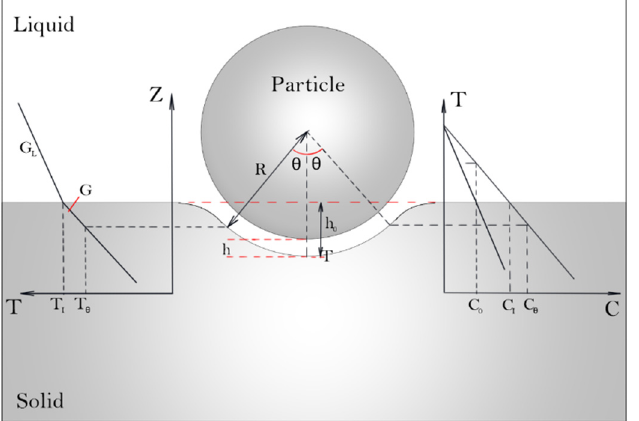
Figure 2. Schematic illustration of the temperature and solute fields in the gap between a particle and an advancing solid–liquid interface.